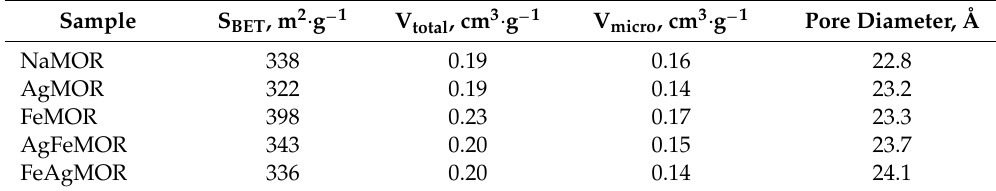
Table 3. Textural properties of the studied